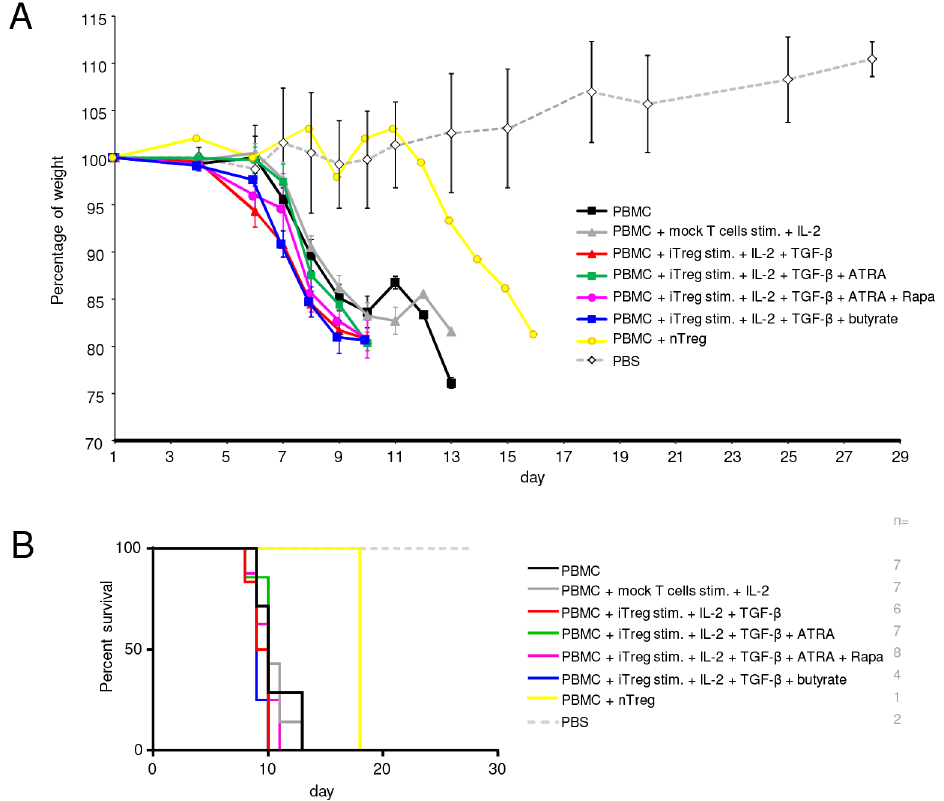
Fig 6. Analysis of suppressive function of human iTregs in vivo in xenogeneic GvHD. iTregs were induced 6 days under the indicated conditions, then washed and rested for 2 days. Allogeneic PBMCs were isolated and CD25-depleted the day before injection. NOG mice were irradiated and injected intravenously on the same day with 20x10 6 PBMCs alone or together with 5x10 6 iTregs or mock control T cells or expanded nTregs in PBS. As control, irradiated mice received PBS only. Mice were weighed every 1 to 3 days. (A) Shows percentage of mouse weight as mean +/- SEM for n = 4 to 8 mice per iTreg group combined from 2 independent experiments; mouse numbers (n) are indicated in the figure (B). (B) Shows the corresponding survival curves for the data from (A). There were no significant differences when comparing each iTreg group to either PBMC only or mock T cell